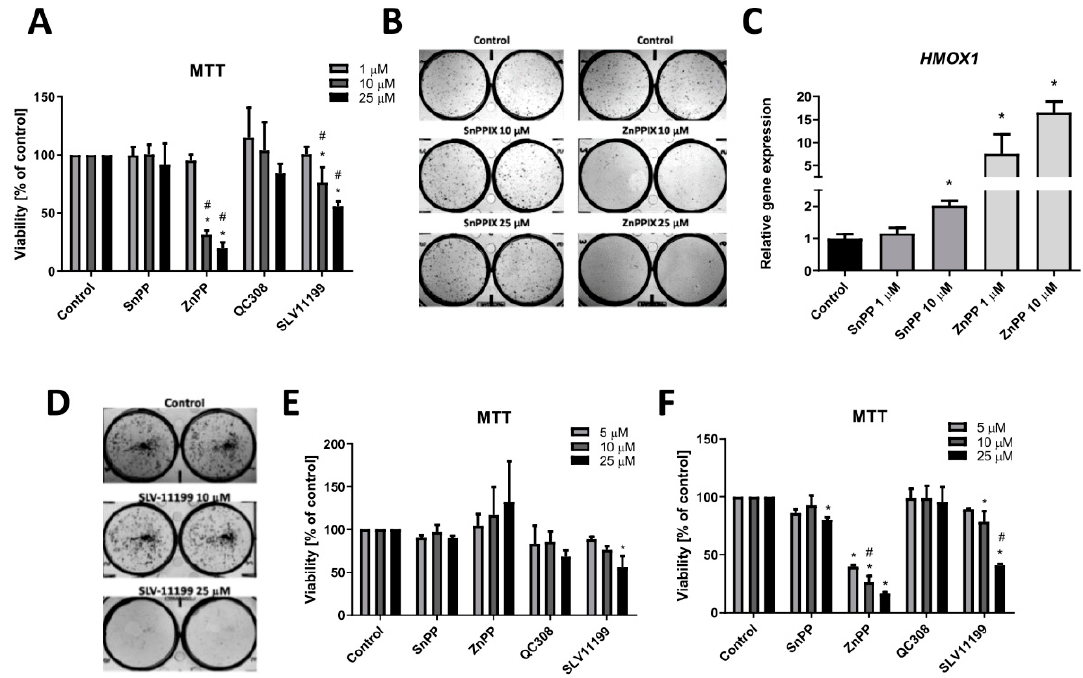
Figure 5. The e ff ect of HO activity inhibitors on FH-deficient cell viability and clonogenic potential. ( A ) Treatment of UOK 262 cell line with 1–25 µ M SnPPIX / ZnPPIX for 72 h. MTT assay results presented as the percentage of control, non-stimulated cells (mean ± SD). ( B ) Representative pictures of colony formation assay on the UOK 262 cell line after 10 days of stimulation with 10 and 25 µ M SnPPIX / ZnPPIX. ( C ) qRT-PCR results of HMOX1 expression in UOK 262 cells after 24 h stimulation with 1 and 10 µ M SnPPIX / ZnPPIX. Results presented as relative fold change (mean ± SD) ( D ) Representative pictures of colony formation assay on the UOK 262 cell line after 10 days of stimulation with SLV-11199. NCCFH1 ( E ) and UOK 268 ( F ) cell viability after treatment with SnPPIX, ZnPPIX, QC-308, and SLV-11199 for 72 h. MTT assay results presented as percentage of control, not stimulated cells (mean ± SD). * p < 0.05